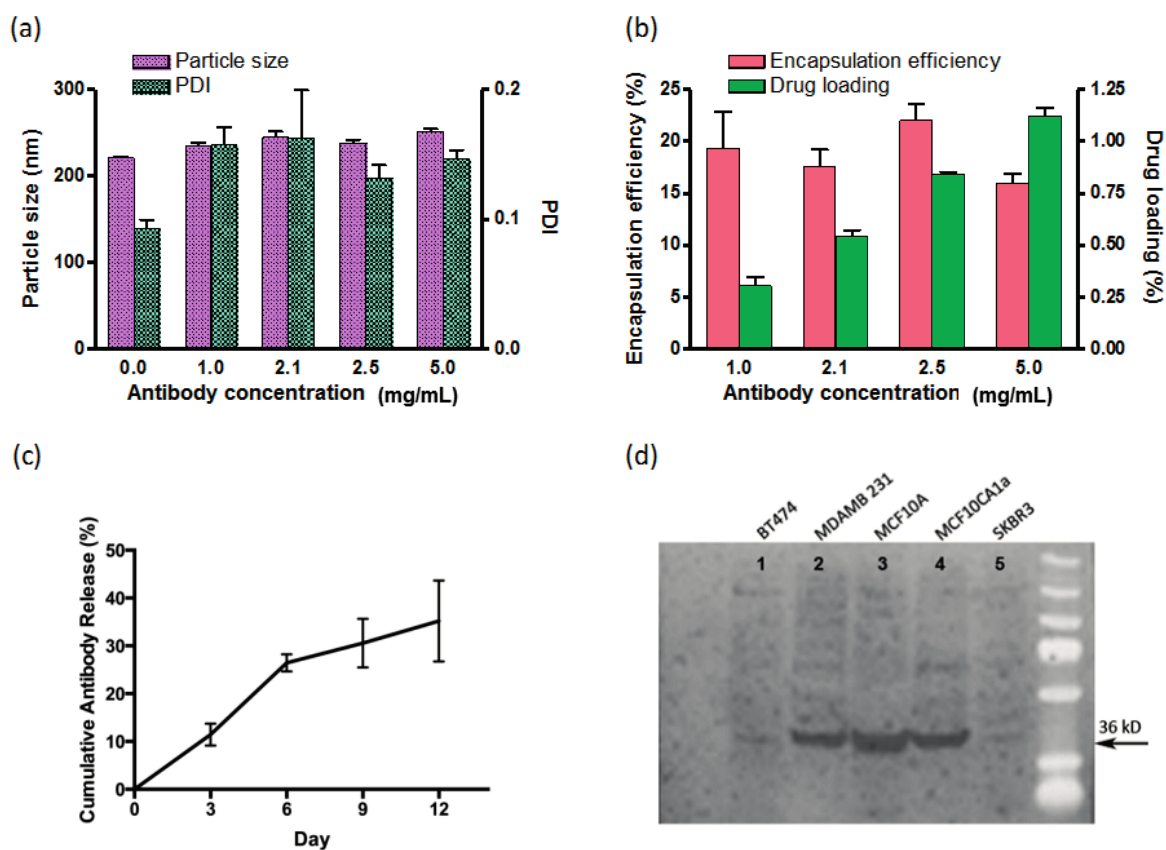
Figure 1. Characterization of anti-Anx A2 antibodies encapsulated within poly(lactic- co - glycolic acid) (PLGA) nanoparticles. ( a ) Dynamic Light Scattering (DLS) measurement of the size and polydispersity index (PDI) of the nanoparticles; ( b ) Encapsulation efficiency and drug loading of the nanoparticles; ( c ) Twelve day cumulative antibody release experiment; and ( d ) Immunoblot of whole cell lysates from breast cancer cell lines showing functional binding of released AnnexinA2 (AnxA2) antibody from the nanoparticle at 36 kD. The BT474 and SKBR3 cell lines are known to have very low AnxA2 expression. MDAMB231, MCF10A, and MCF10CA1a cell lines are known to have high AnxA2 expression. (Bars represent standard error of the mean, n =